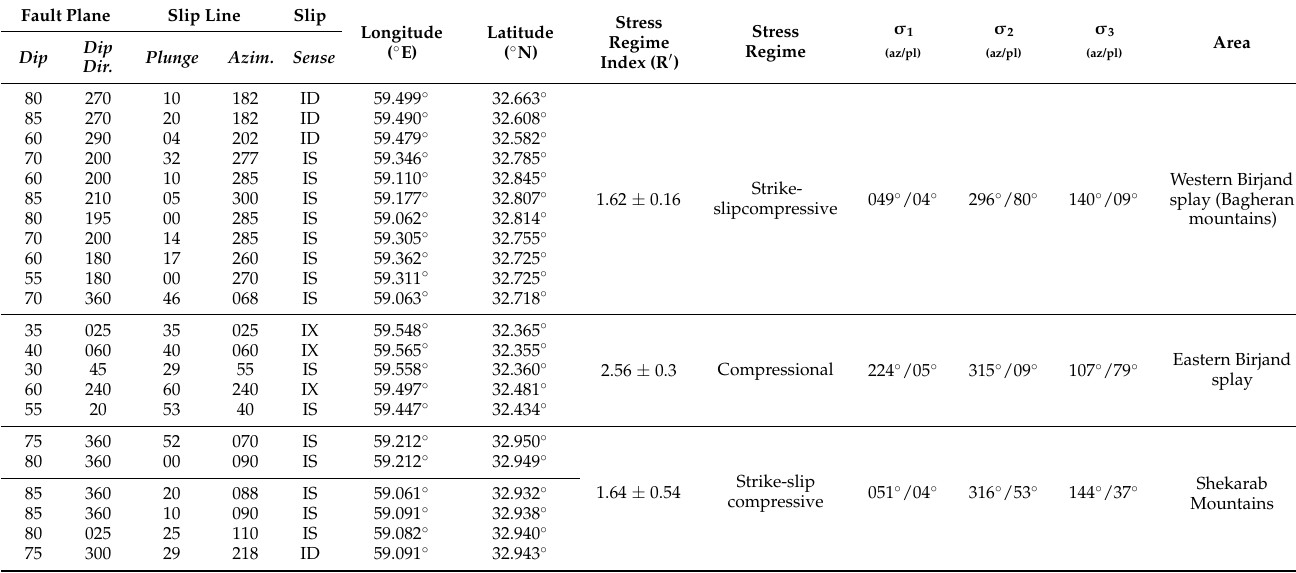
Table 2. The azimuth (az) and plunge (pl) of the main principal stress axes, computed from the fault slip data ( σ 1 , σ 2 , σ 3 ) for the study area. Senses IS, ID, IX are inverse sinistral, inverse dextral, and pure reverse dip-slip, respectively.